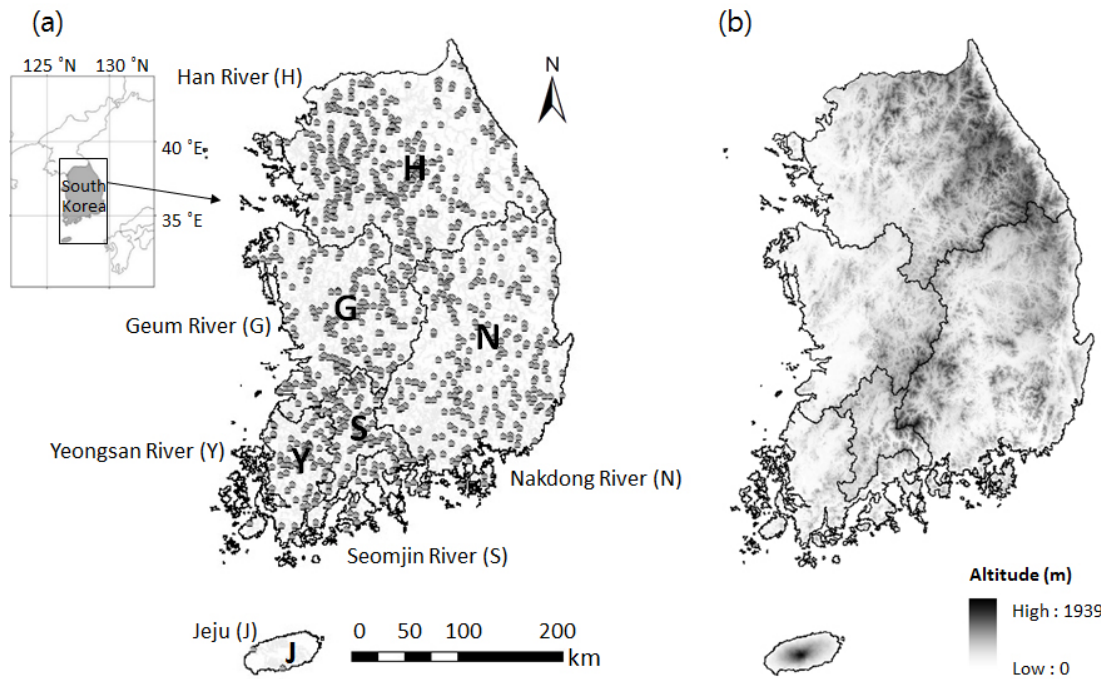
Figure 1. ( a ) Location of sampling sites; and ( b ) altitudinal map of South Korea.